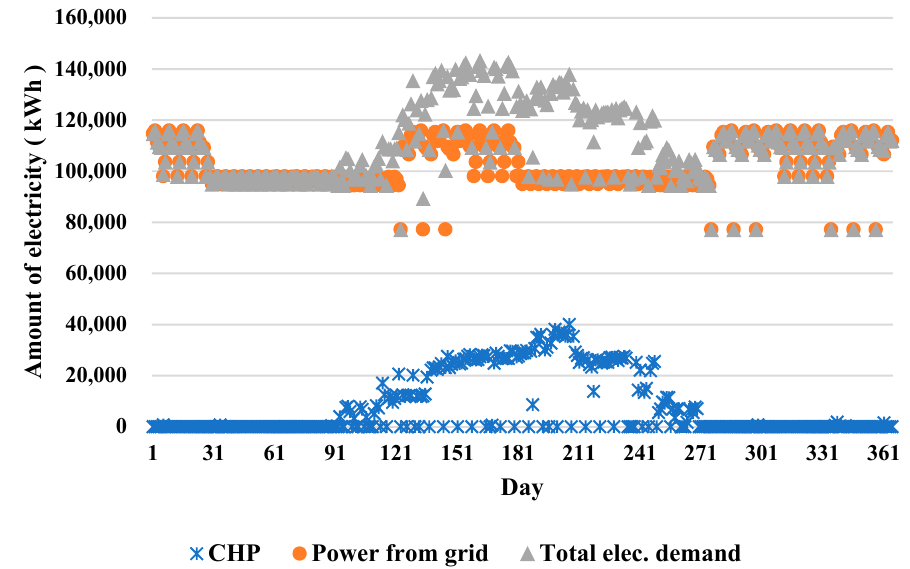
Figure 6. Annual daily profile for the power supply and demand for Case B.